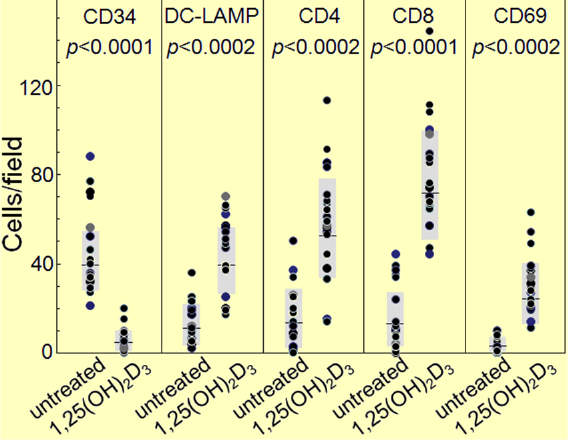
Figure 9. Quantitation of increased immune infiltration within HNSCC tissue of patients treated with 1,25(OH) D 2 3